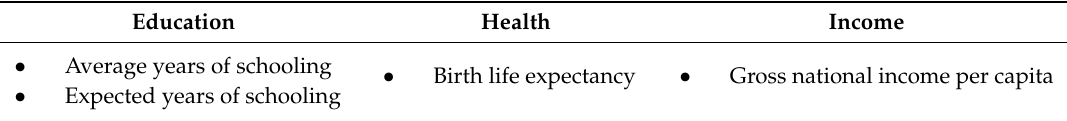
Table 2. Elements of UN’s Human Development Index